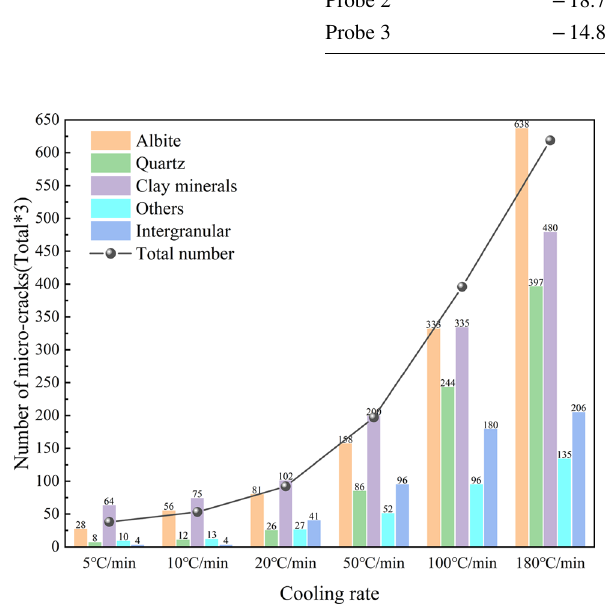
Table 2 The temperature (°C) of each probe when the temperature boundary is −30 °C